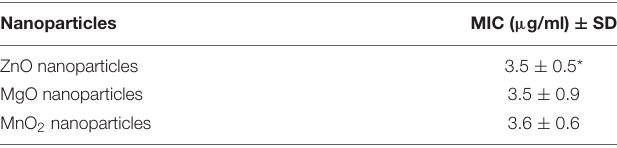
TABLE 1 | The minimum inhibitory concentration (MIC) of ZnO, MgO, and MnO 2